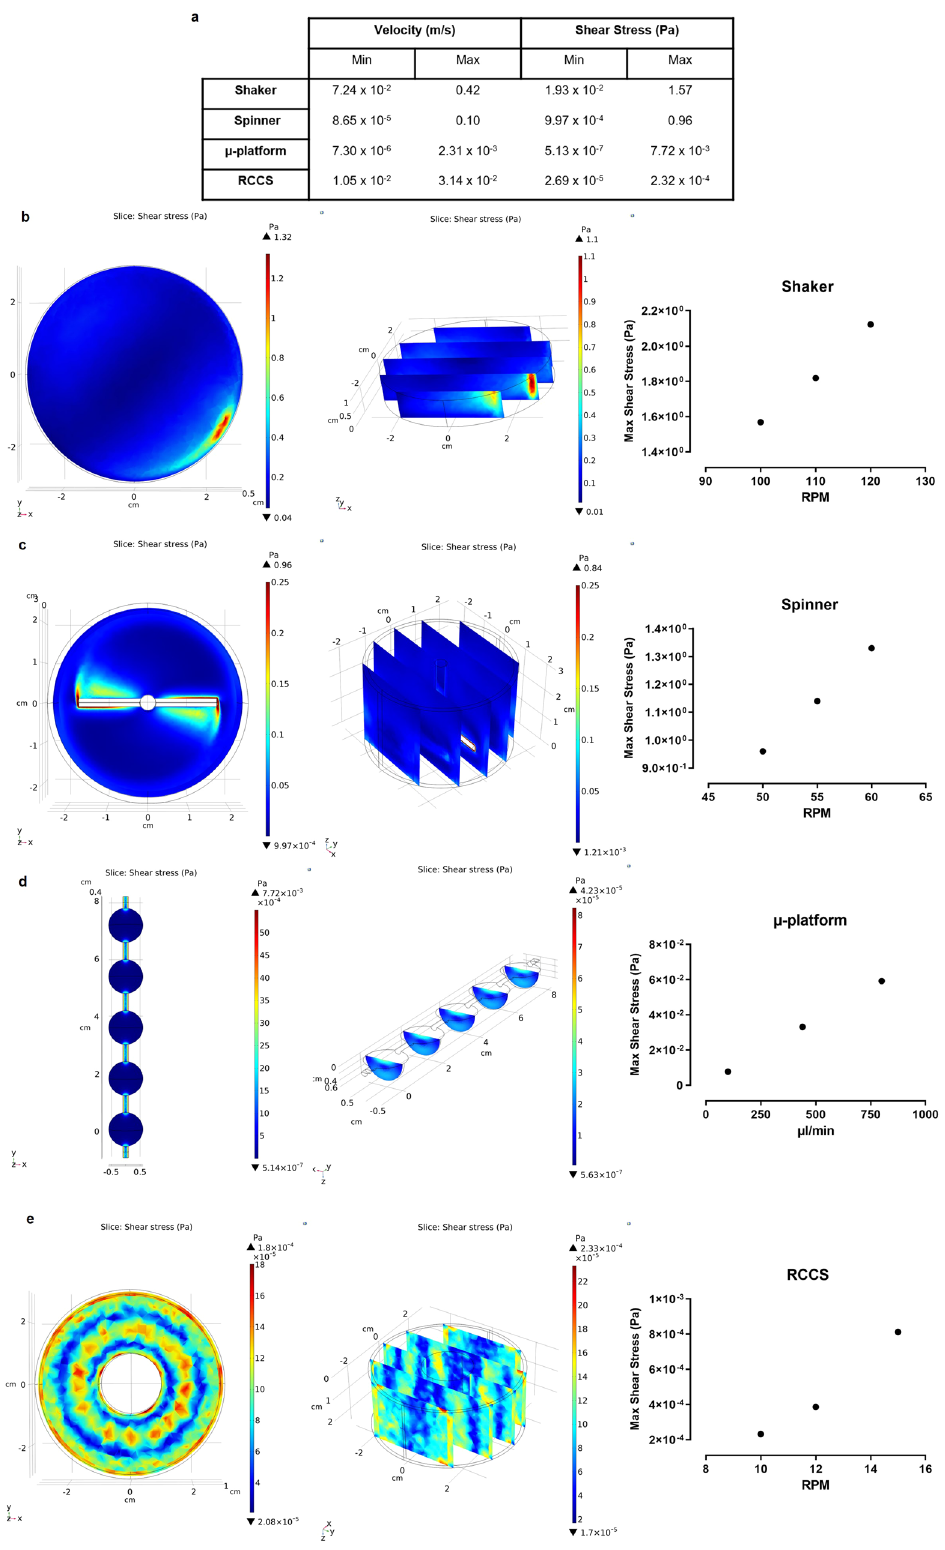
Fig. 1 Results of computational fl uid dynamics (CFD) simulations using fi nite element commercial code COMSOL Multiphysics. a Min and max values of velocity and shear stress at initial fl ow conditions. Numerical simulations of shear stress for; b shaker, c spinner, d µ -platform, and e RCCS-microgravity